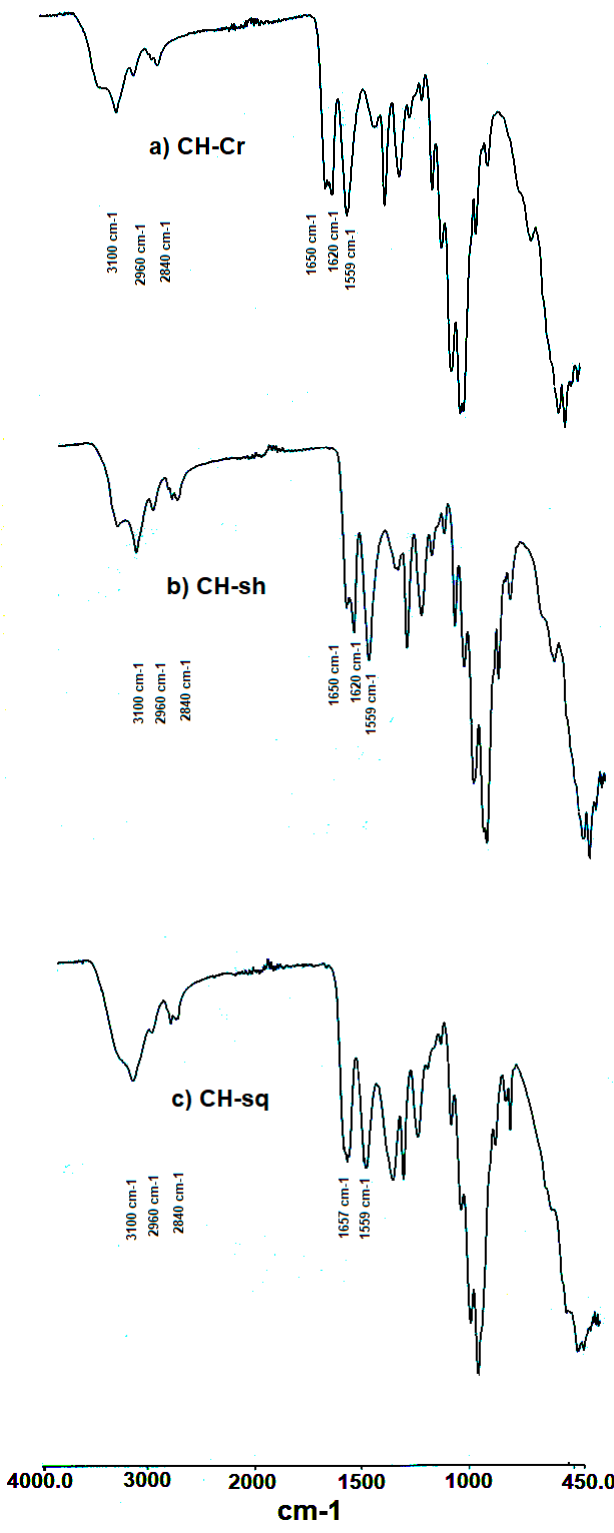
Figure 1. FTIR spectra of ( a ) CH-Cr, ( b ) CH-Sh ( b ), and ( c ) CH-Sq.